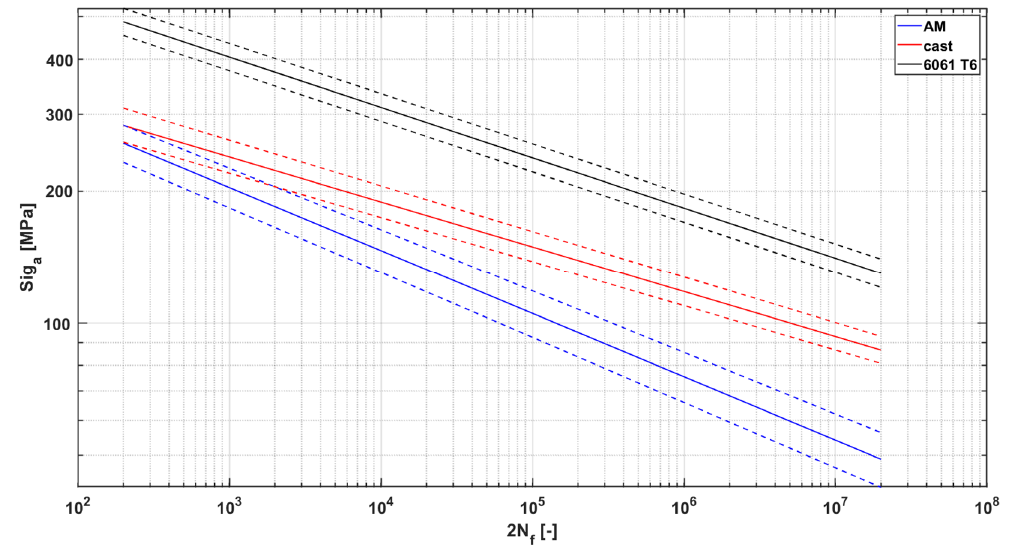
Figure 9. Comparison of Basquin curves for each analysed material.